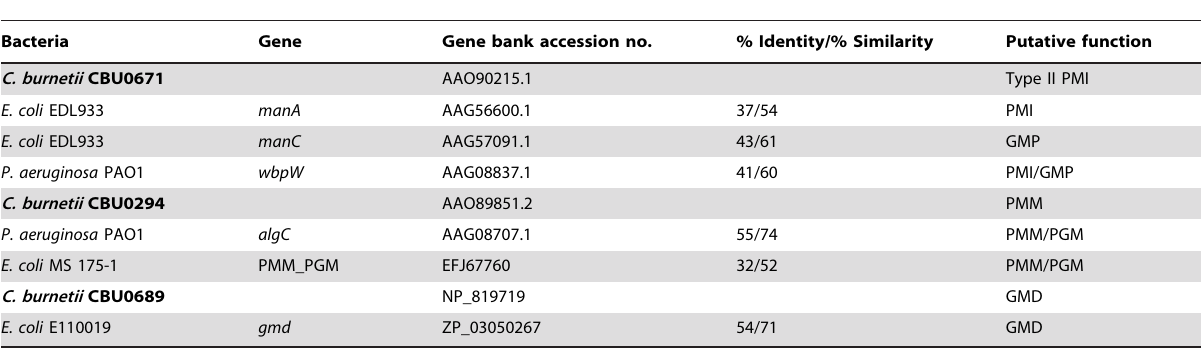
Table 1. Predicted C. burnetii proteins catalyzing formation of GDP-D-mannose.